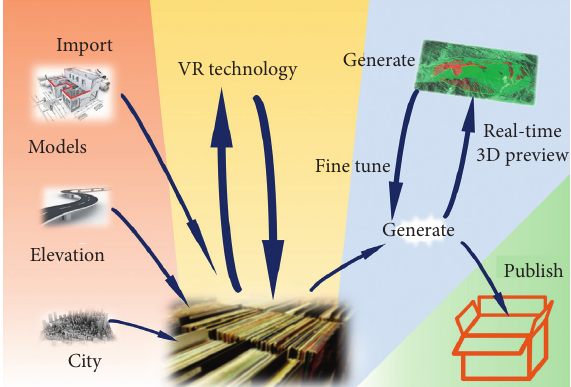
Figure 1: Architecture of the management of the city